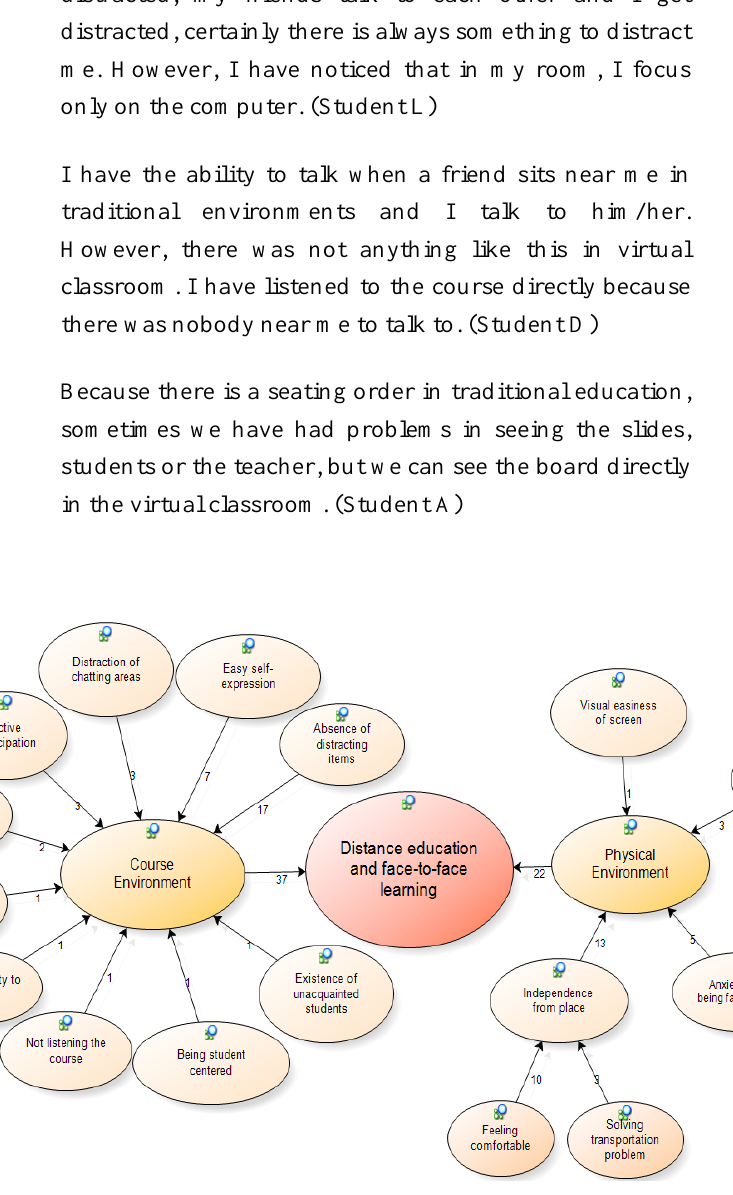
Figure 1. The differences between the distance education process and the face-to-face education